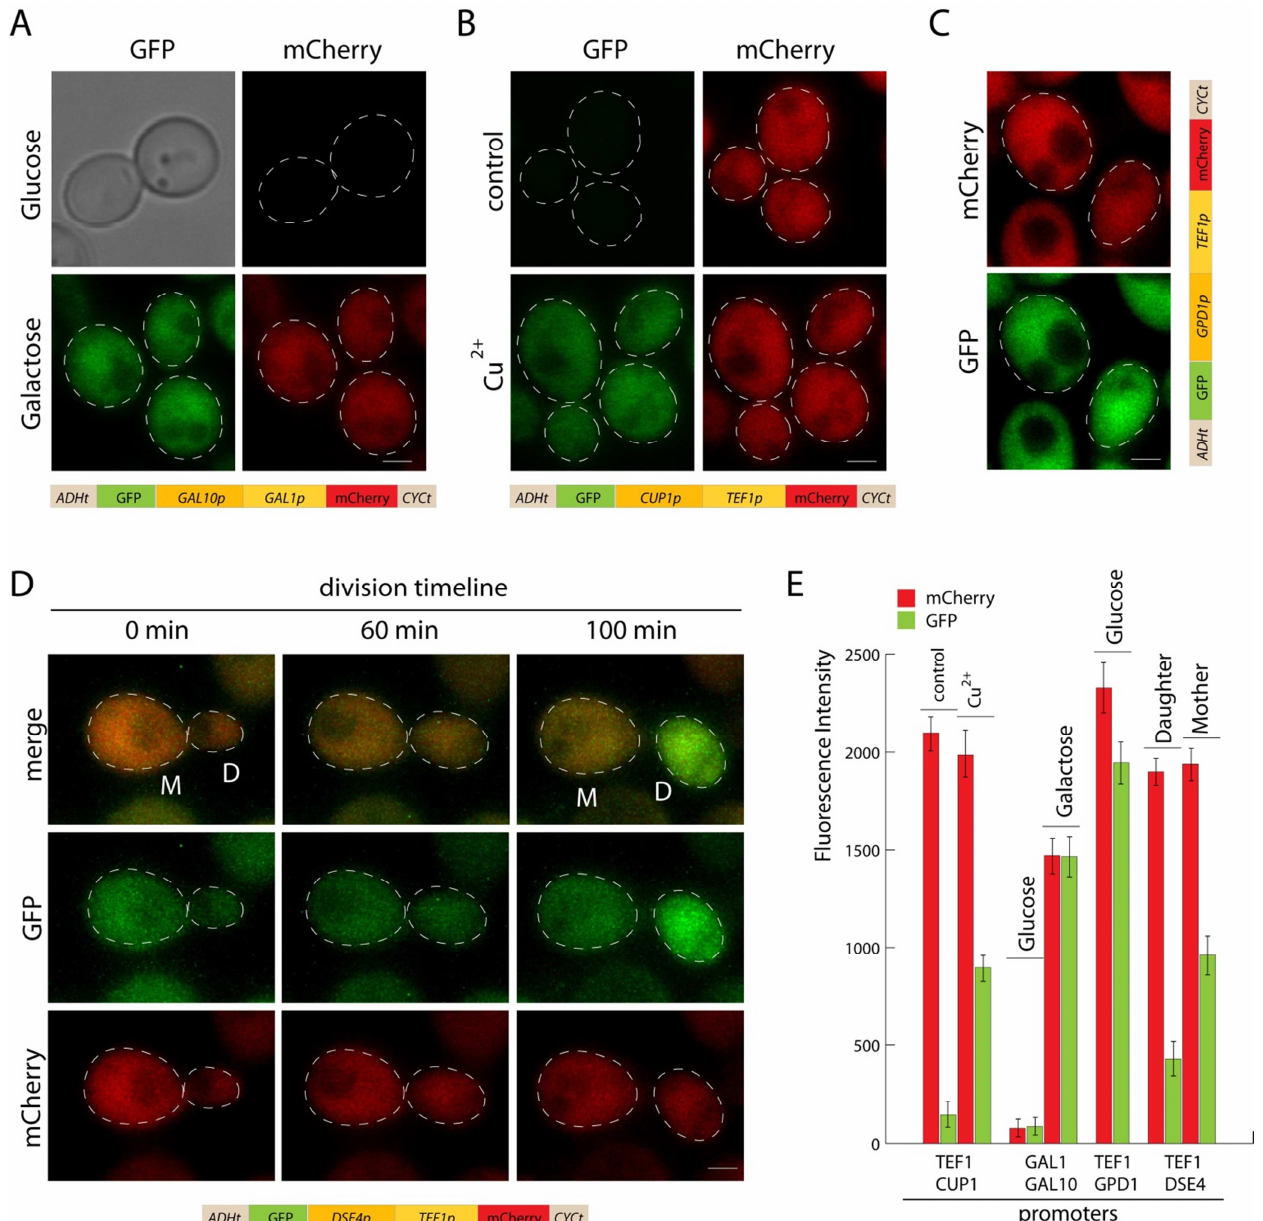
FIGURE 4: Bidirectional promoter reporters. (A) Galactose inducible bidirectional promoter, cells carrying pDK-HGG-GFP-mCherry were induced with galactose or grown on glucose for 6 hours, scale bar 1 µm. (B) Constitutive-inducible promoter, cells carrying pDK-HTC-GFP-mCherry were grown with and without (control) copper2+ for 4 hours, scale bar 1 µm. (C) Constitutive bidirectional promoter, cells carrying pDK-HTG-GFP- mCherry were grown on glucose containing medium to middle log phase, scale bar 1 µm. (D) Daughter-specific-constitutive bidirectional pro- moter, cells carrying pDK-HTD-GFP-mCherry module were grown on glucose containing medium on the microscope, frames are shown (0 min, 60 min, 100 min). (E) Comparison of fluorescence intensity of bidirectional reporters, the graph shows the average of fluorescence intensity of 20 cells and standard